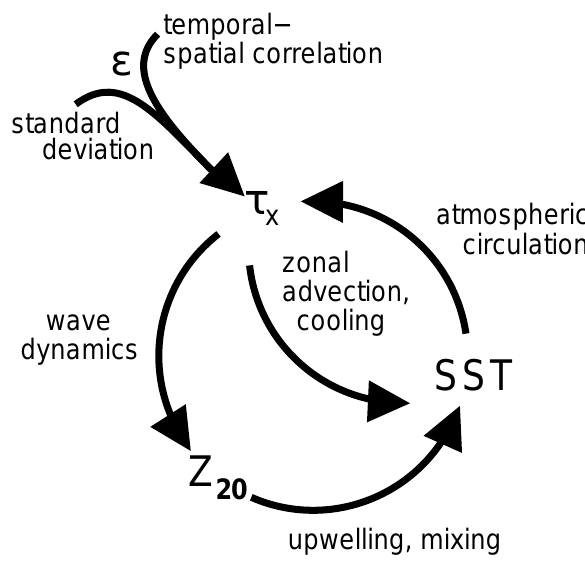
Fig. 1. The main feedbacks between wind stress ( τ x ), SST and thermocline depth ( Z 20 ) in the ENSO phenomenon and the external noise term (cid:15) .